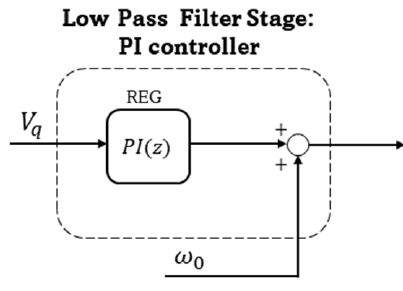
Figure 7. Low-pass filter of the SOGI-PLL.